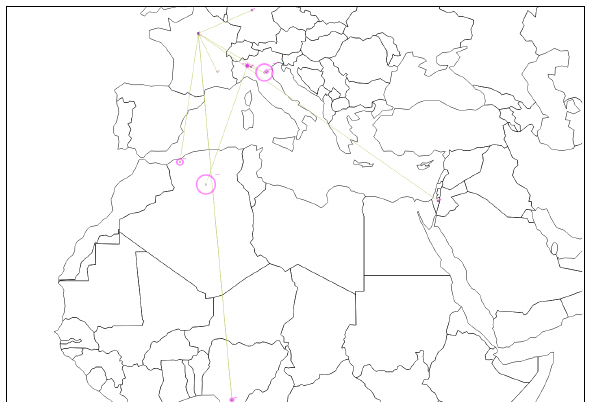
Figure 7. IG of a bread supply chain, average italian practice. The nodes map the amount of non-renewable primary energy used per person in a year (MJ / person * year) and refers to the consumption of 41,7 kg of bread (Magentino-Abbiatense